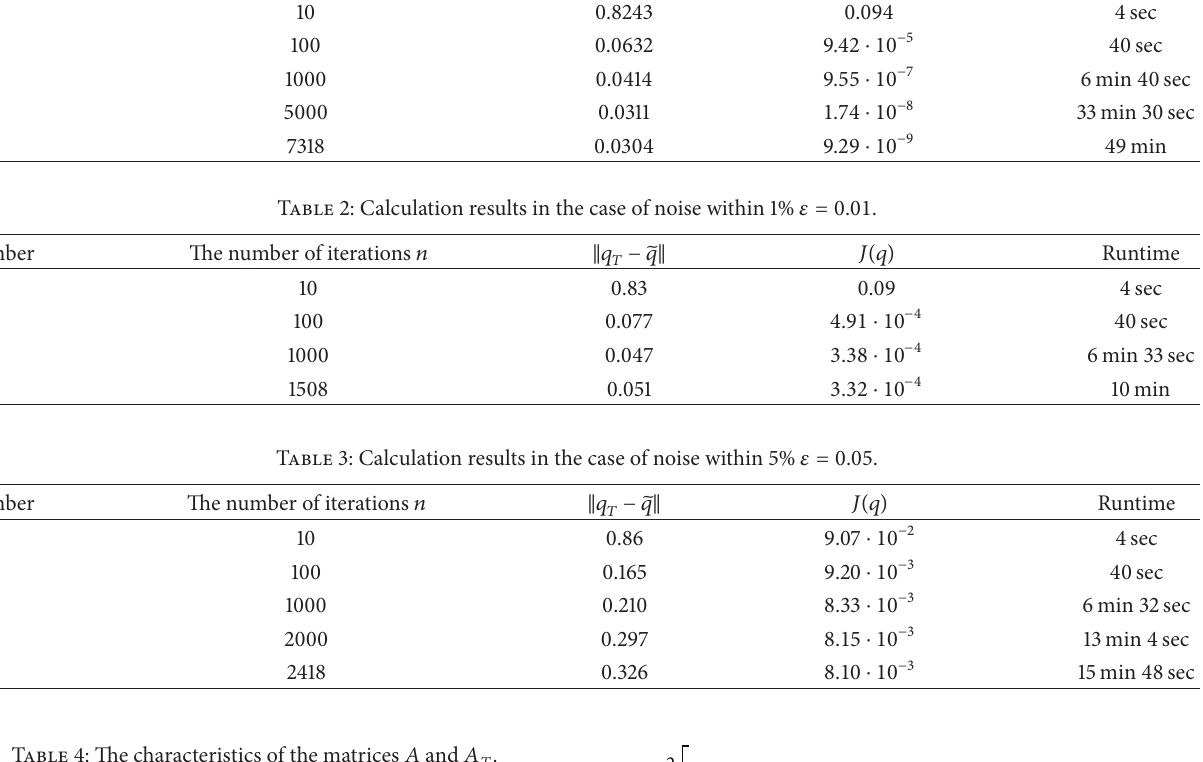
Table 4: The characteristics of the matrices 𝐴 and 𝐴 𝑇 .